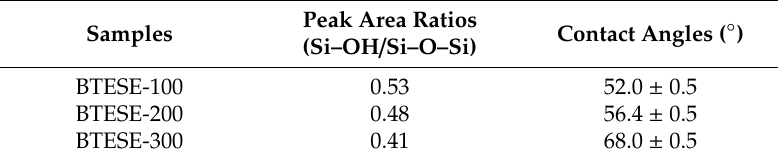
Table 3. In general, the BTESE-100 membrane exhibited higher permeance and lower permeance ratios of H 2 / N 2 and H 2 / SF 6 than the other two membranes, suggesting a looser network structure. On the other hand, the gas permeation performances were similar for BTESE-200 and BTESE-300